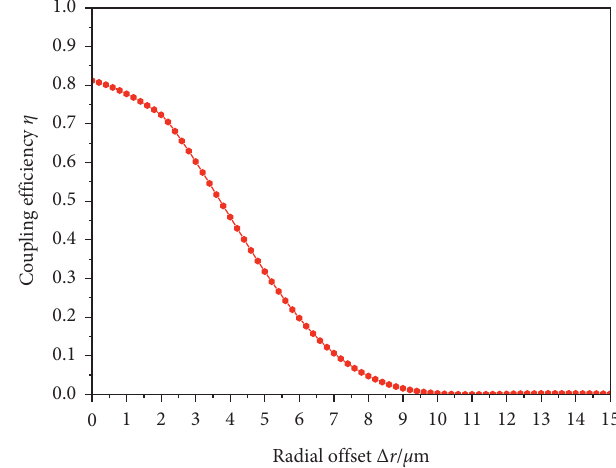
Figure 2: Relationship between the coupling efficiency and fiber